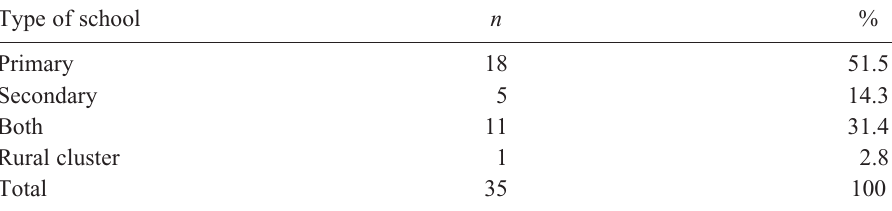
Table 4. Typology distribution of the schools in the